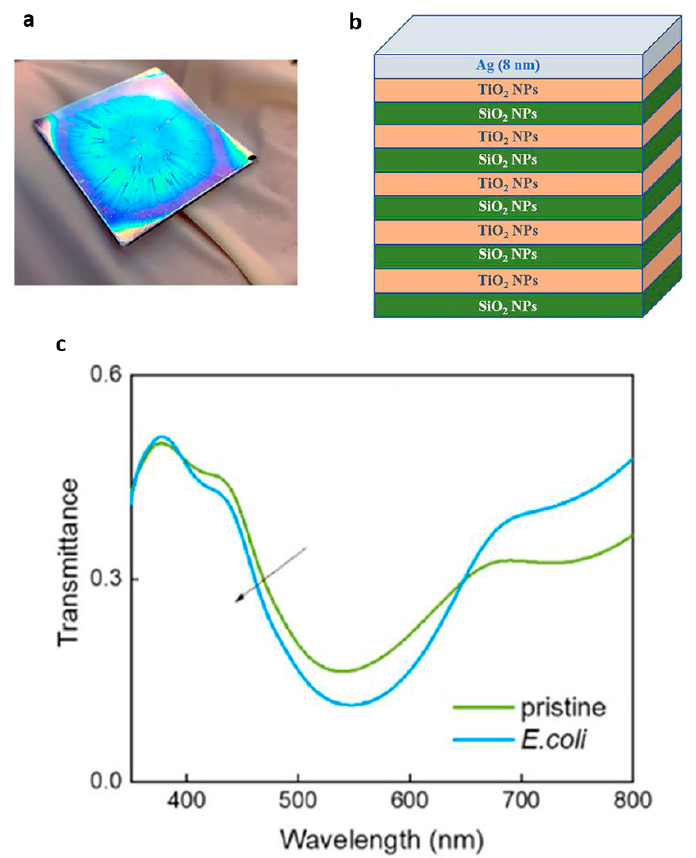
Figure 6. ( a ) Picture of a hybrid plasmonic-photonic crystal and ( b ) sketch of the multilayered structure. ( c ) Optical transmittance before (green) and after exposure to E. coli (blue line). Reproduced with permission from [172]. Copyright © 2019, American Chemical Society.